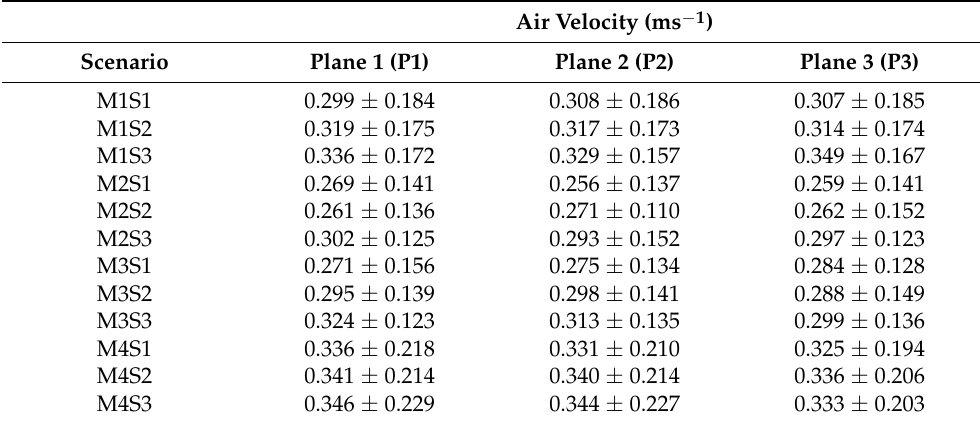
Table 5. Temperature values obtained by simulation in each scenario